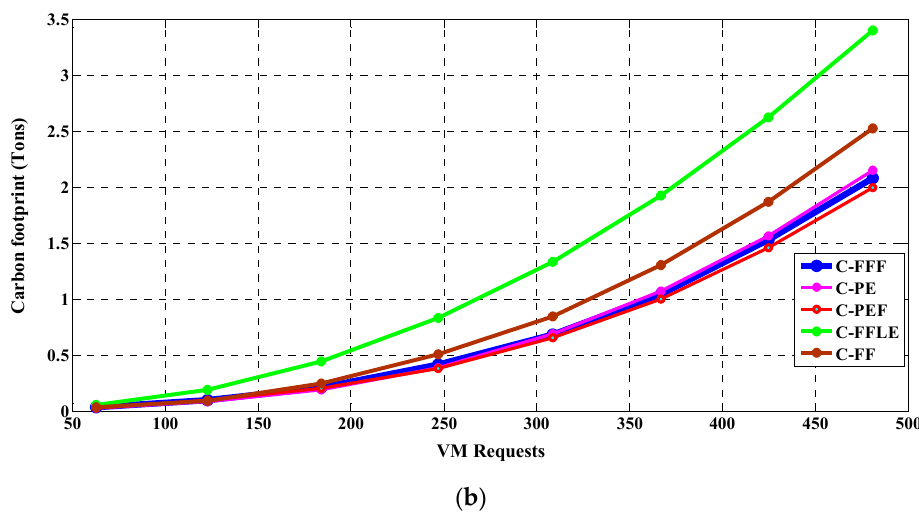
Figure 6. ( a )Power consumption and ( b ) carbon footprint of all algorithms with 100% RVA.